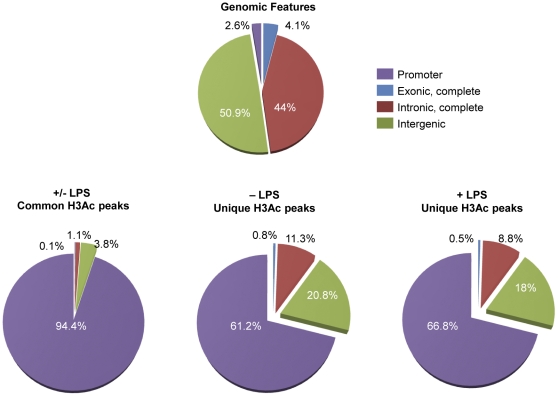
Distribution of H3Ac peaks across the macrophage genome.Graph (A) shows a summary of the expected distribution of genomic features of the whole human genome (2.9 billion base pairs). Graph (B) shows the location of common H3Ac peaks from the macrophage genome. (C) & (D) show the location of unique H3Ac peaks in macrophages during the experimental conditions, unstimulated (−LPS) and LPS-stimulated (+LPS), respectively.